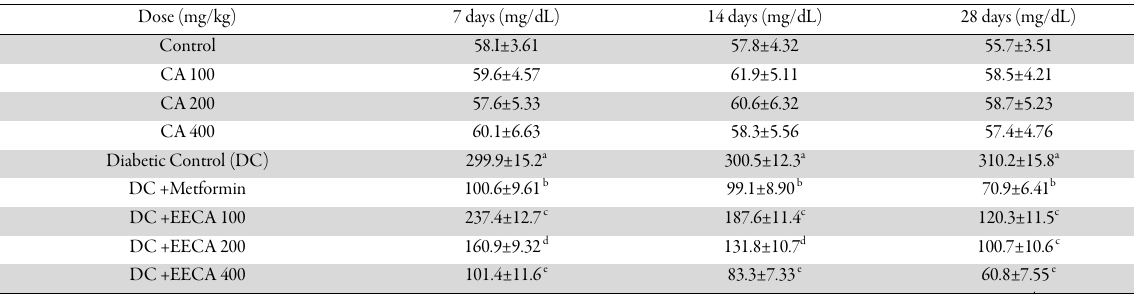
Table 5. Effect of Chrysophyllum albidum on serum triglyceride level of alloxan-induced diabetic rats